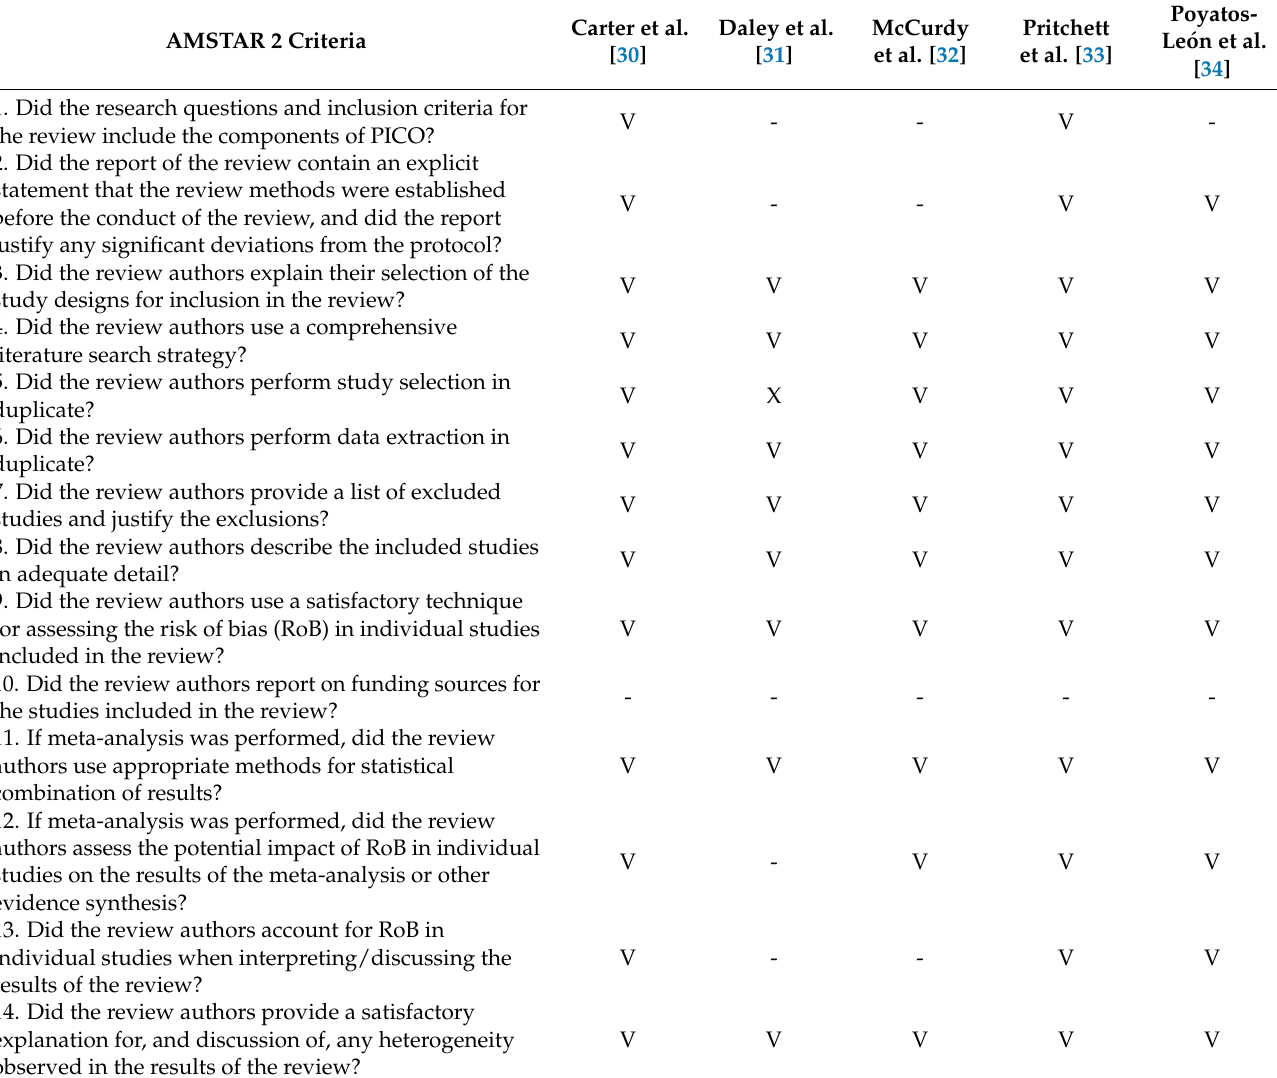
Table 2. Quality of the meta-analyses according to the AMSTAR 2